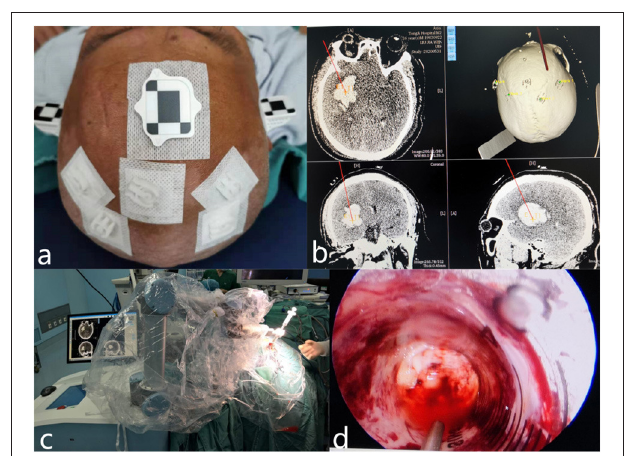
FIGURE 1 | Representative images of robot-assisted neuroendoscopic hematoma evacuation combined ICP monitoring surgical workflow. (a) Markers were attached to the temple and forehead of the patient, and then CT scans were performed before the operation. (b) The entry point, the range of hematoma, and optimal trajectory were carefully planned by the surgeon. (c) After the dura matter was incised, a sheath with stylet inside was inserted into the hematoma cavity with the assist of a Remebot robot. (d) The hematoma was removed under